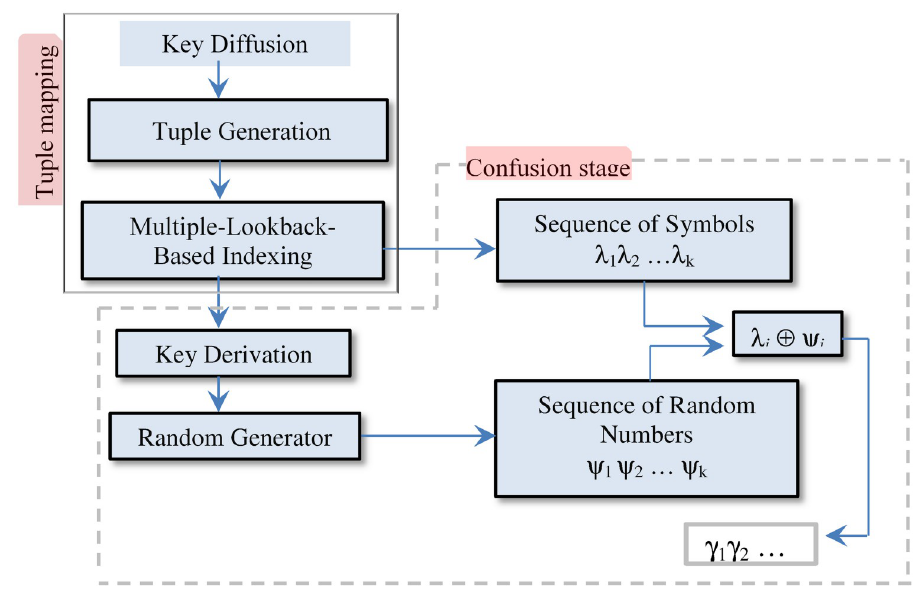
Fig 11. The key expansion process reproduced from